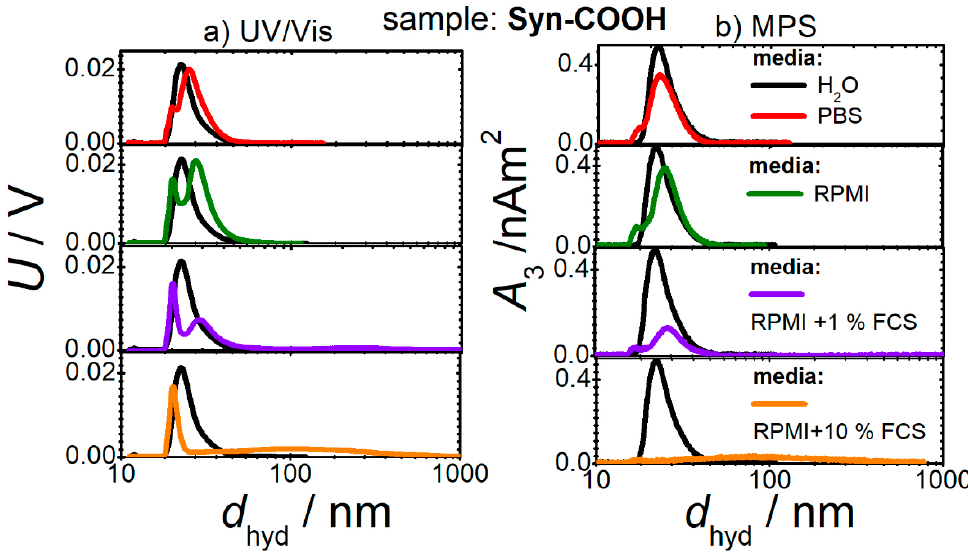
Figure 1. Iron concentration ( c (Fe)) (obtained from ( a ) UV/Vis) and magnetic amplitude ( A 3 ) (mea- sured by ( b ) MPS) as a function of hydrodynamic diameter ( d hyd ) obtained (by DLS) during CF3 separations of Syn-COOH in four different